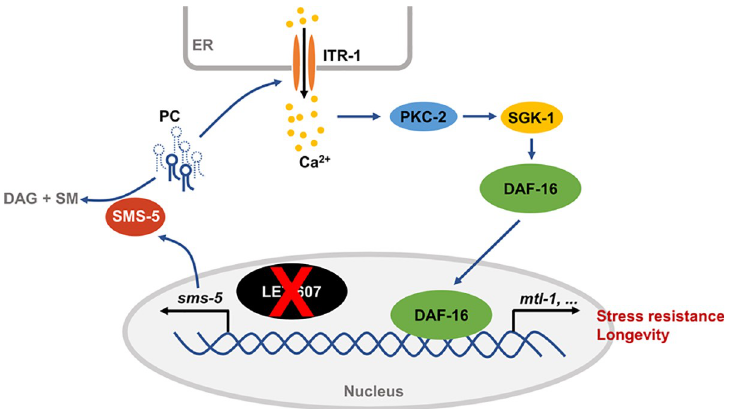
Fig 8. Communication model between the LET-607 and DAF-16 pathways. Suppression of LET-607 induces the expression of sms-5 , which reduces unsaturated PC contents. This may in turn affect the ITR-1 calcium channel on the ER membrane. Calcium released by ITR-1 activates DAF-16 via calcium-sensitive kinase PKC-2 and downstream kinase SGK-1.